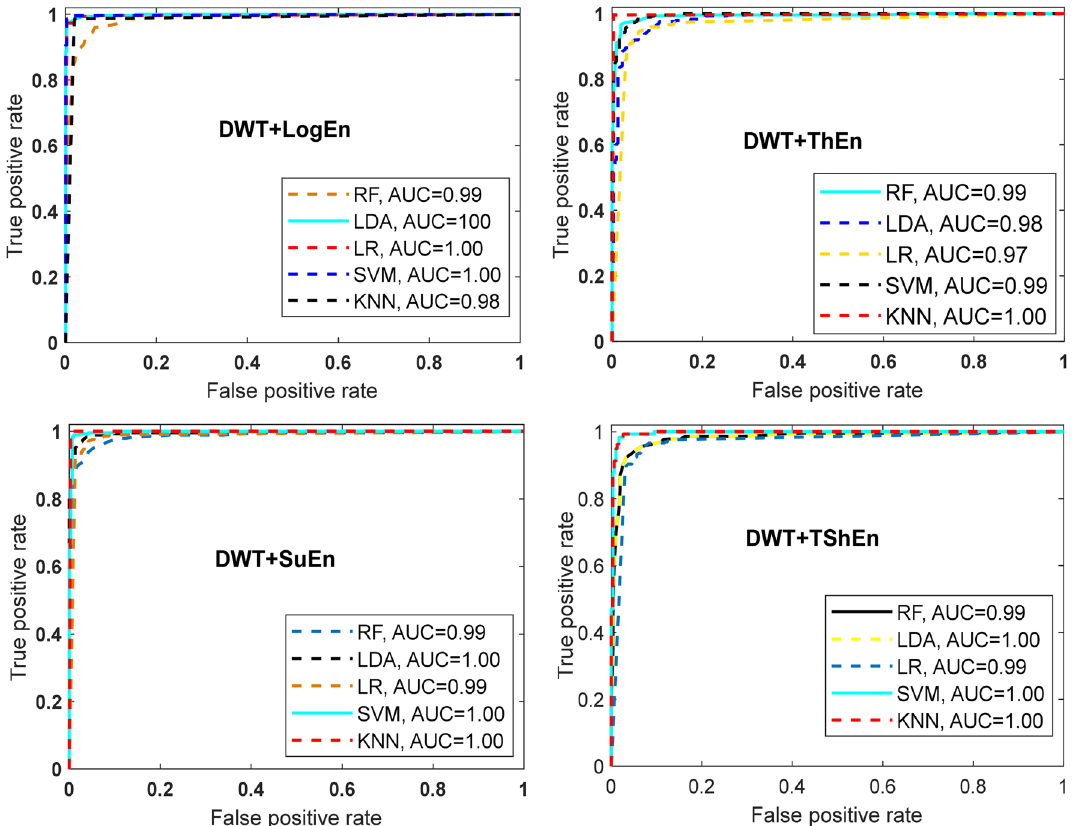
Figure 6. ROC-AUC of off-PD versus HC classification based on features extracted from four methods.